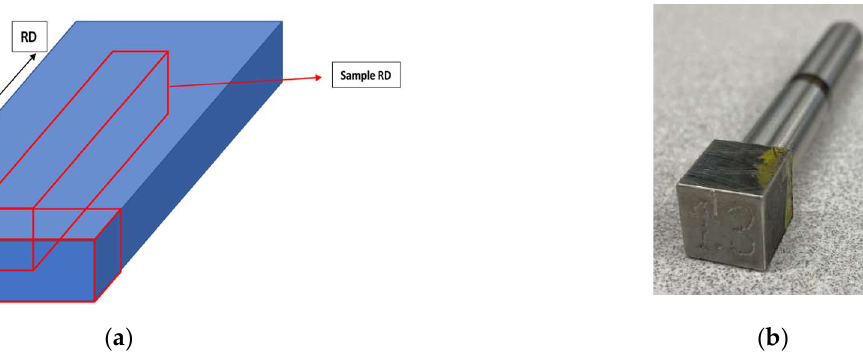
Figure 2. ( a ) Illustration of how the cuboid samples were cut from the cold-rolled samples. ( b ) Photograph of the sample after turning, where some part of the original cuboid was left untouched to keep track of the material axes.